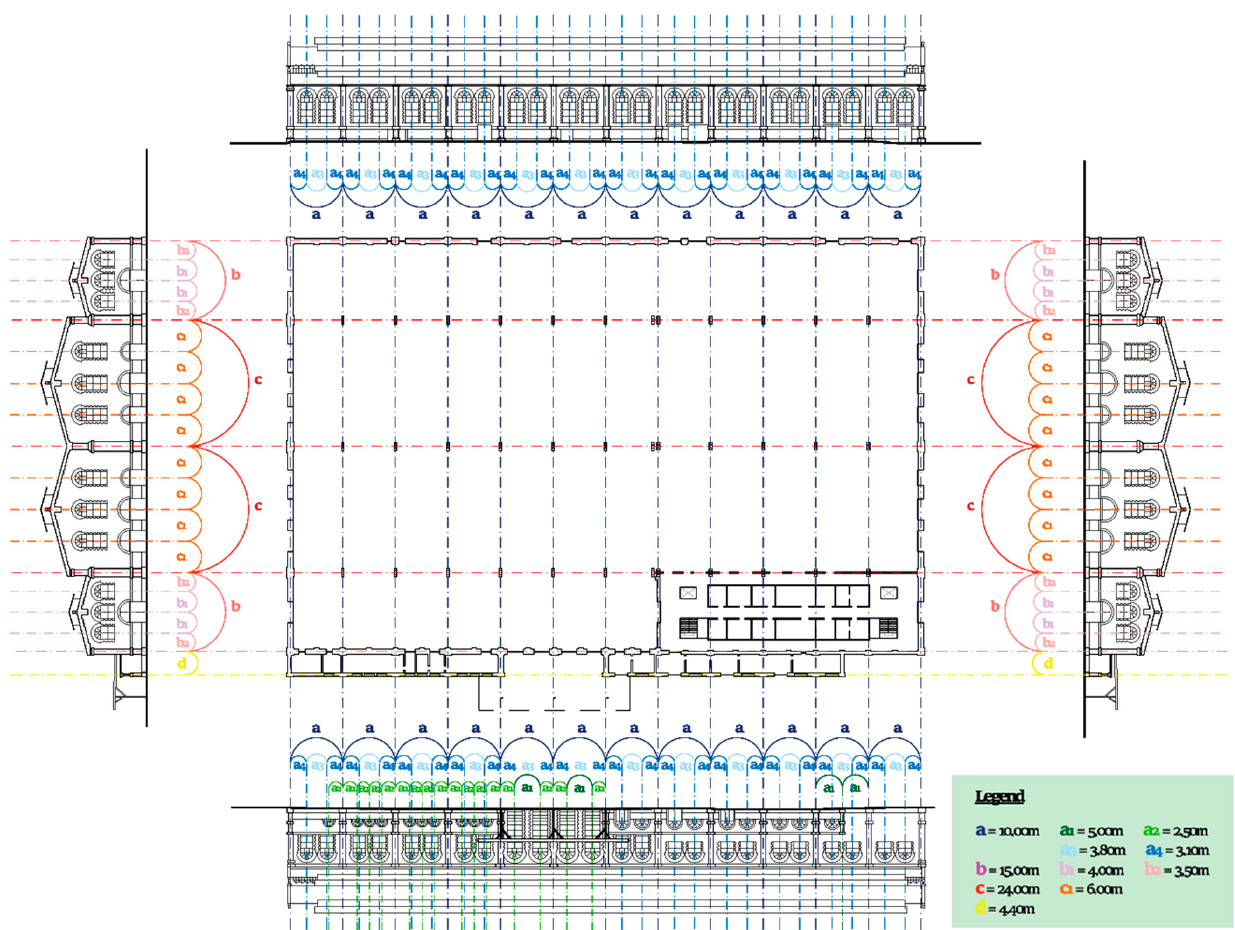
Figure 3. Identi fi cation of the modular rhythm of the “Nave de Talleres Generales”. Figure 3. Identification of the modular rhythm of the “Nave de Talleres